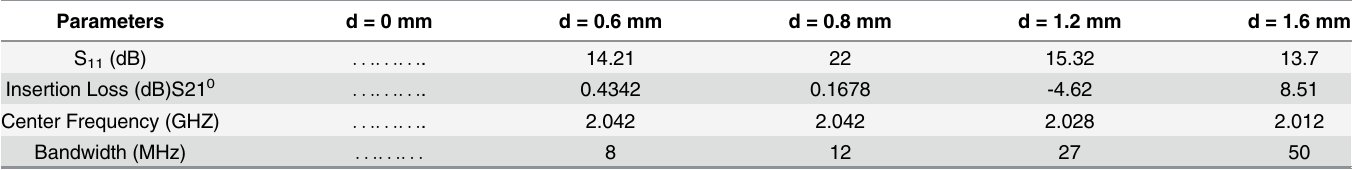
Table 1. Simulation Result Parameters of Slotted Patch BPF With Respect to d